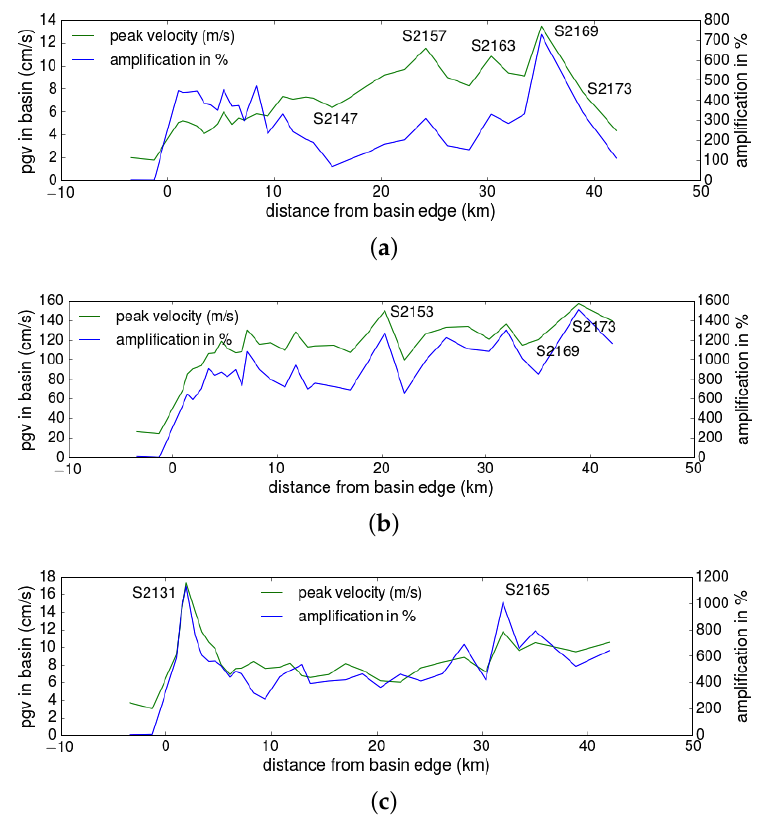
Figure 12. Peak velocity at stations plotted as a function of distance from the basin edge, generated for ( a ) crustal fault, ( b ) megathrust, and ( c ) intraslab scenarios. Blue and green curves represent peak velocity in the basin stations and amplification (in %), respectively. Selected station names are indicated by labelled dots.